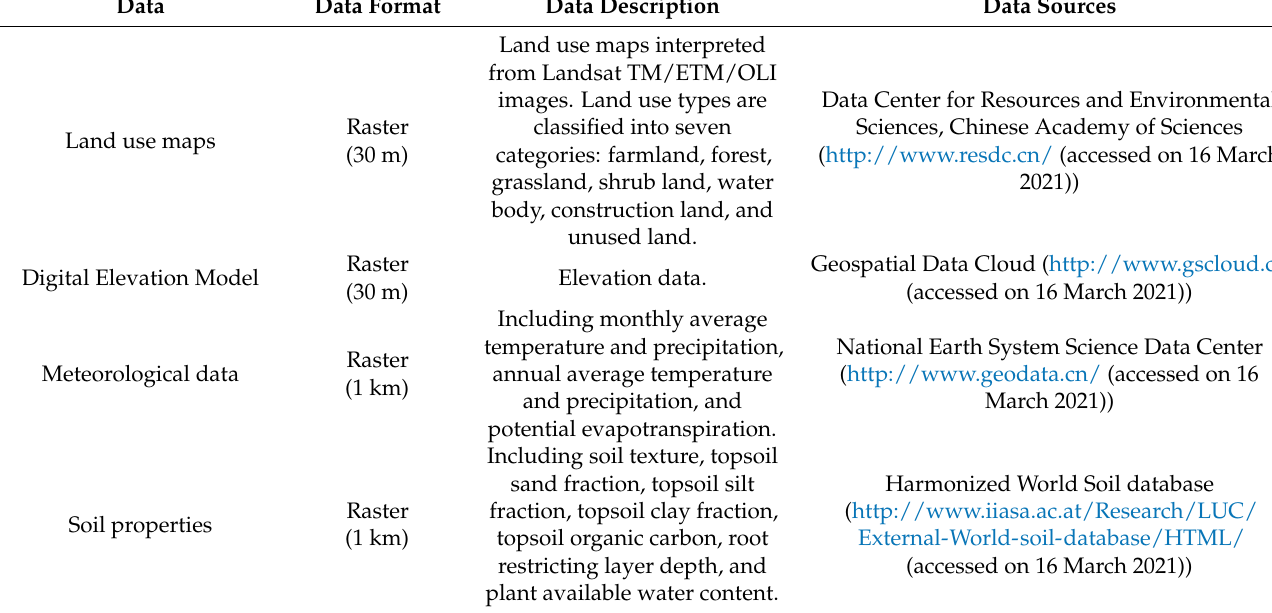
Table 1. Description and sources of data used to evaluate ESs.